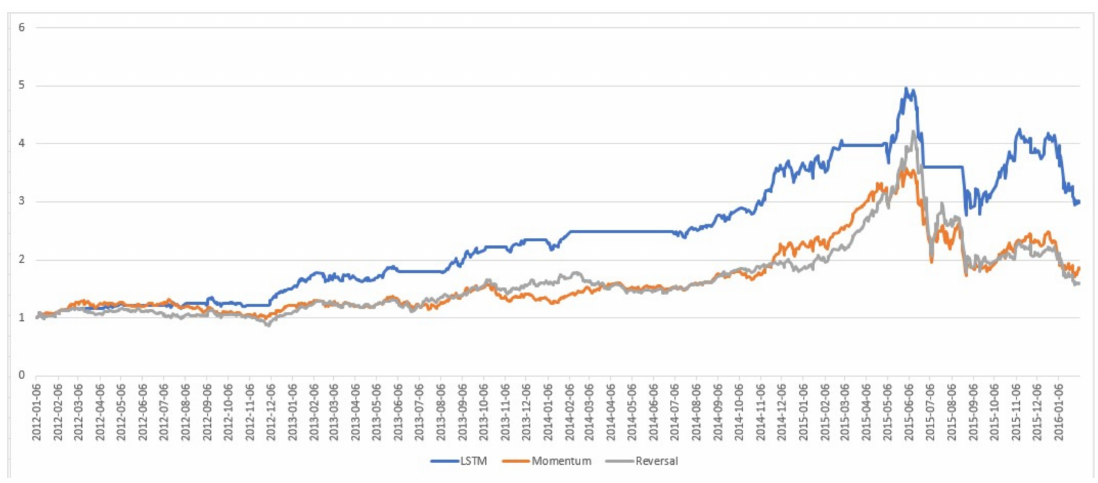
Figure 8. Portfolio performance comparison for the LSTM.